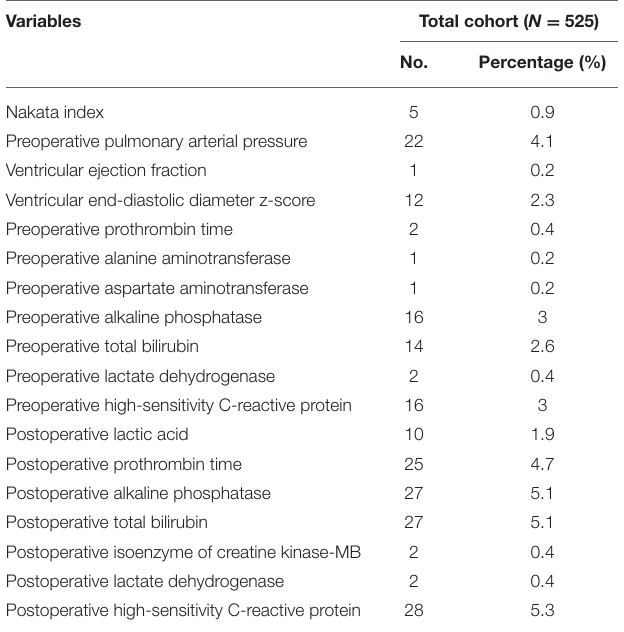
TABLE 1 | Missing